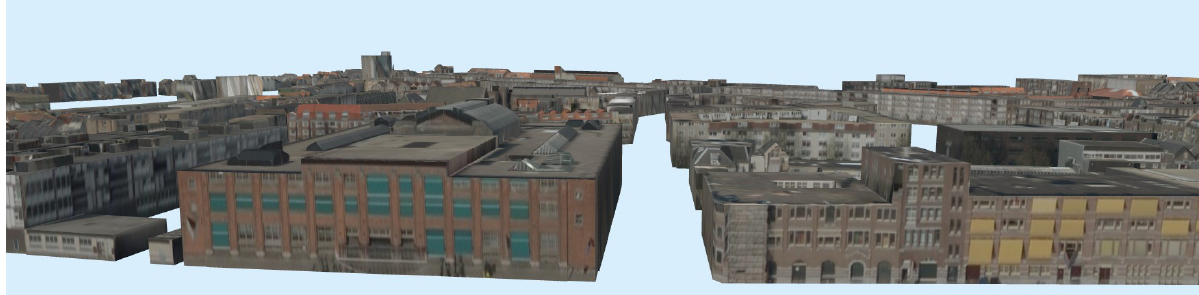
Figure 4. Demo of our work-in-progress support for textures in ninja ’s 3D